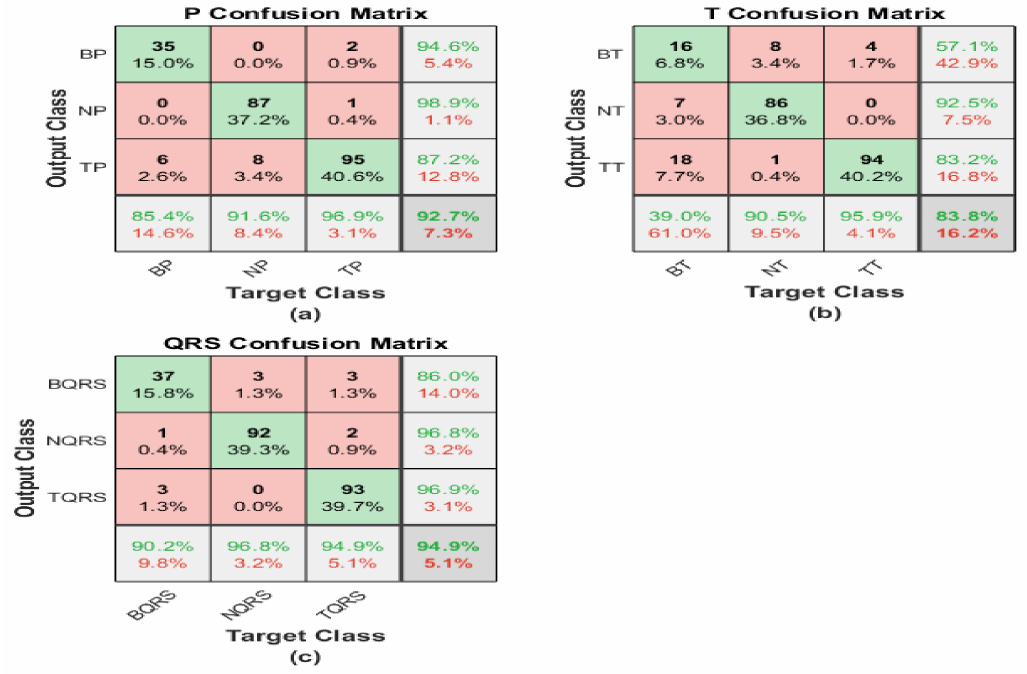
Figure 10. Confusion matrices of ECG irisgram using ResNet101: ( a ) P-waves irisgram; ( b ) T-waves irisgram; ( c ) QRS waves